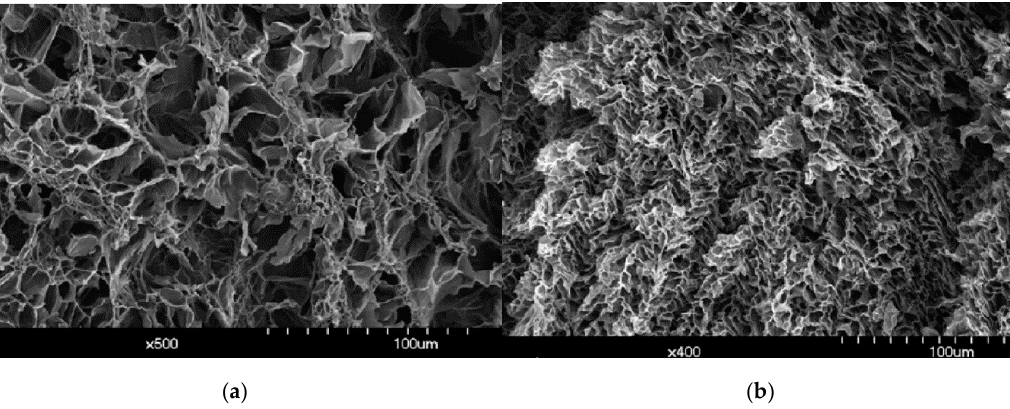
Figure 3. Scanning electron microscope micrographs of ( a ) a polyacrylamide polymer hydrogel and ( b ) nanocellulose content hydrogel. The figure above was adapted with permission from the cited reference [79].